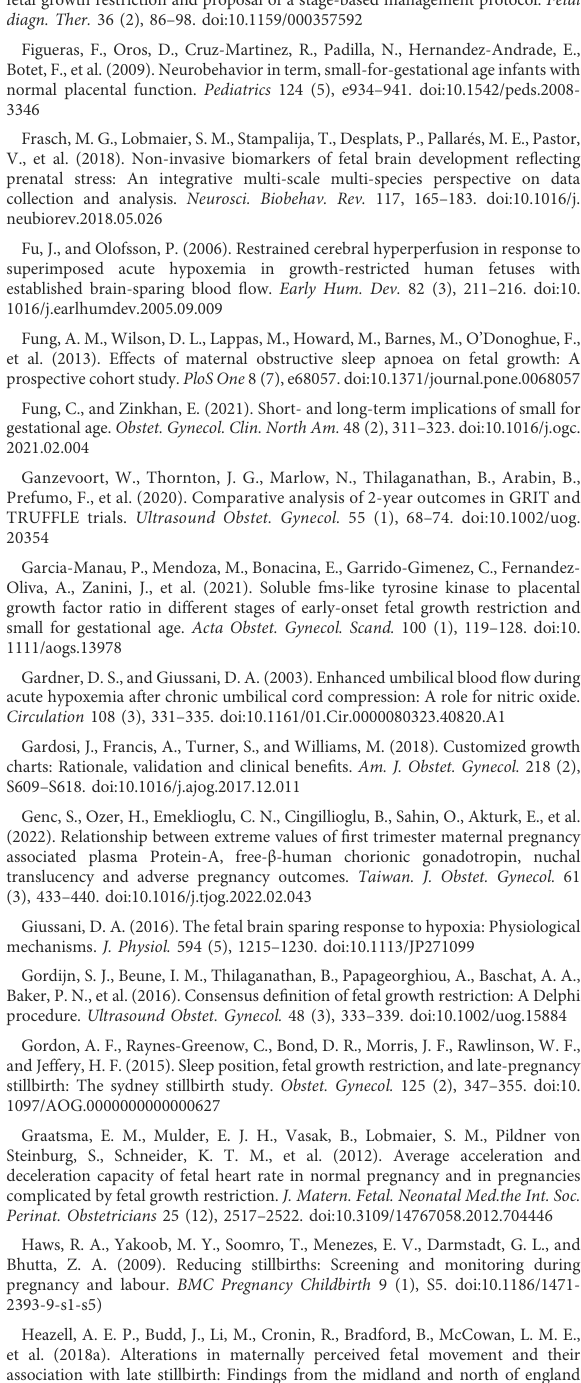
Figueras,F.,andGratacós,E.(2014).Updateonthediagnosisandclassi fi cationof fetal growth restriction and proposal of a stage-based management protocol. Fetal diagn. Ther. 36 (2), 86 – 98.